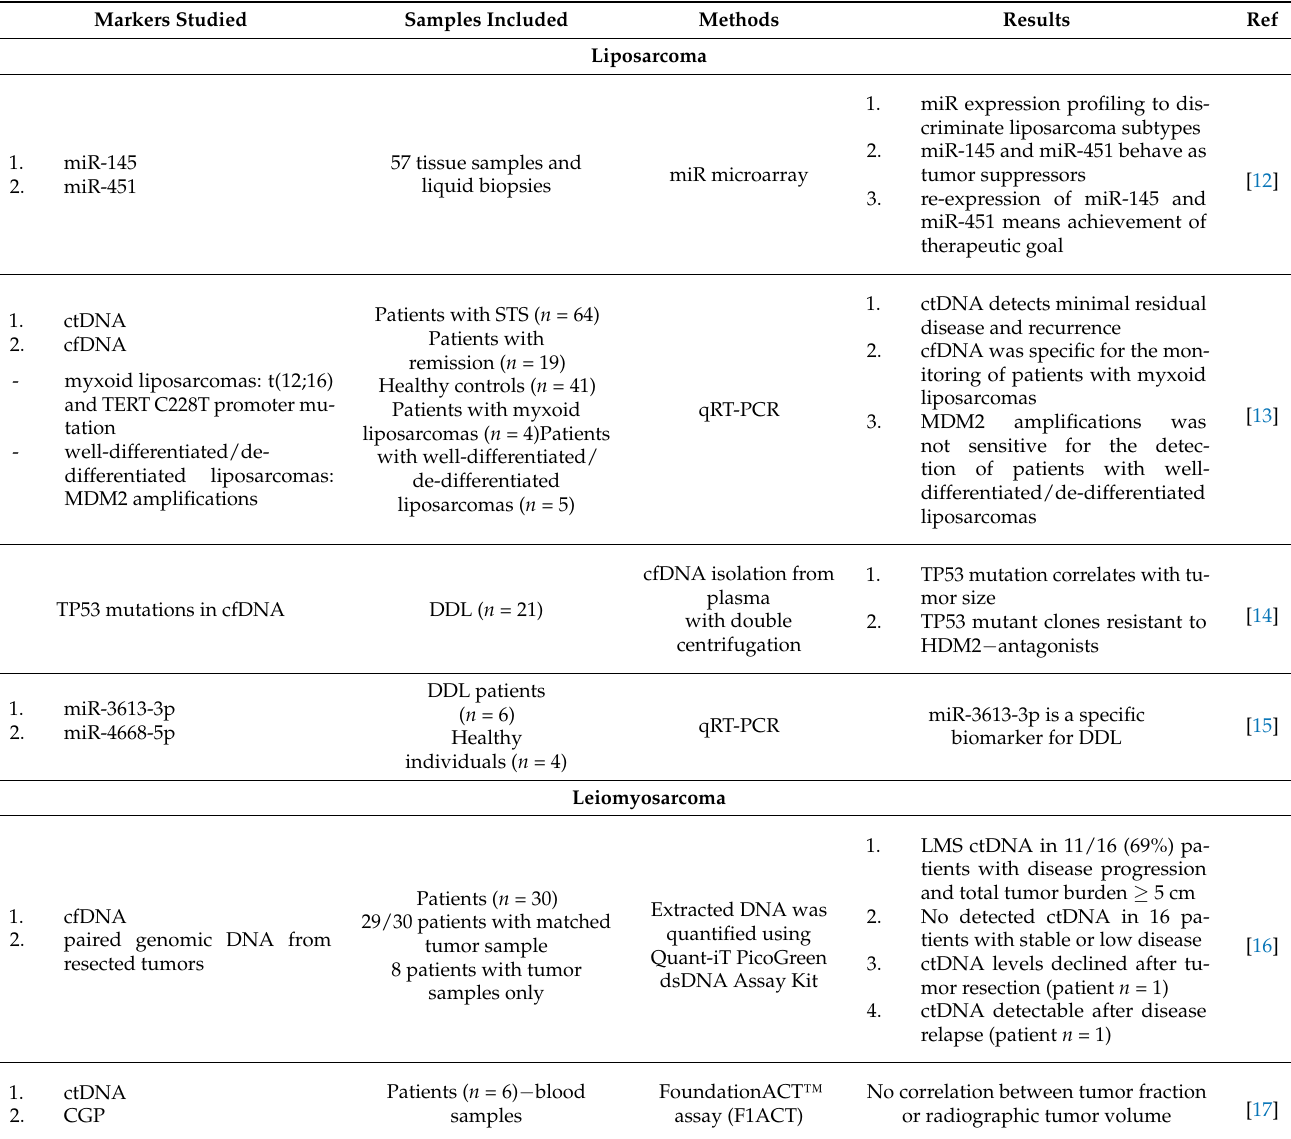
Table 1. Markers studied through the liquid biopsy technique in soft tissue sarcomas, number of samples, methods utilized and results